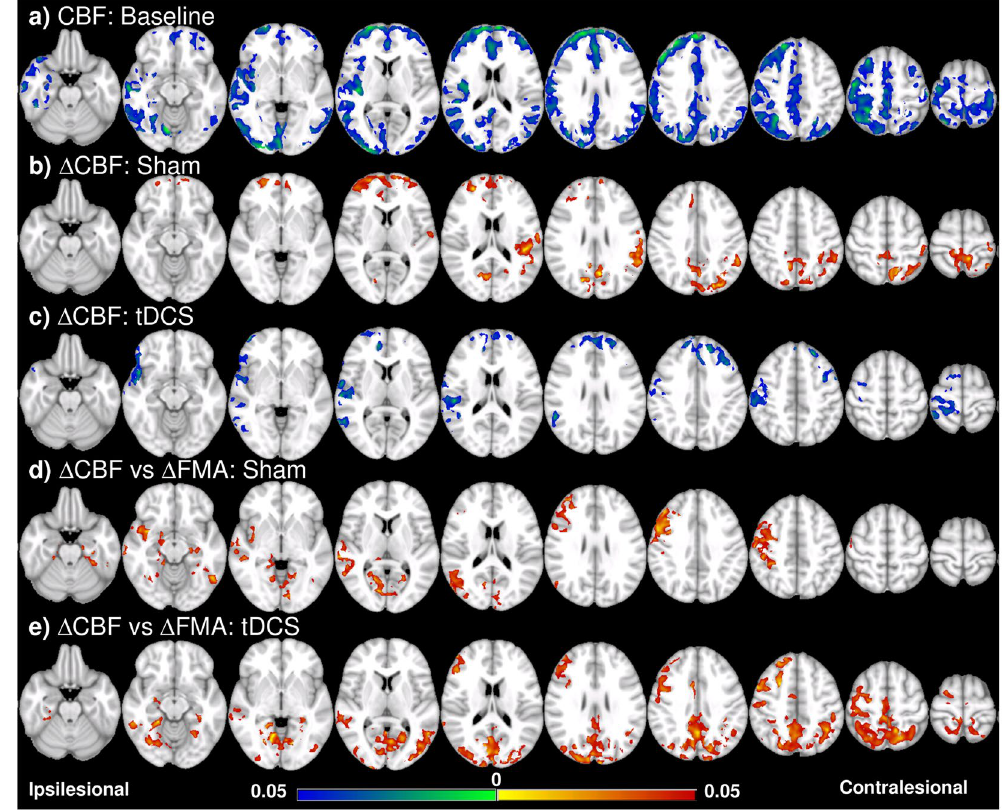
Figure 4. Voxel-wise CBF analysis and behavioral correlation. ( a ) CBF of all the patients (tDCS and sham groups together) is lower especially in the ipsilesional hemisphere compared to the control at the baseline. ( b ) CBF increase in the frontal and contralesional side after training in the sham group. ( c ) CBF decrease in the frontal and ipsilesional side after training in the tDCS group. ( d ) ∆ CBF positively correlates with ∆ FMA in the sham group in the ipsilesional side, including the pre/postcentral cortices, angular gyrus, lateral occipital cortex, and middle temporal gyrus, and the ventral occipital lobes in both sides; ( e ) in the tDCS group, positive correlation between ∆ CBF and ∆ FMA is in similar regions as well as the posterior and superior part of the two hemispheres including the posterior parietal cortices. Colorbar represents p-value with hot color as increase (or positive correlation) and cold color as decrease (or negative correlation) (p < 0.05, FWE corrected).